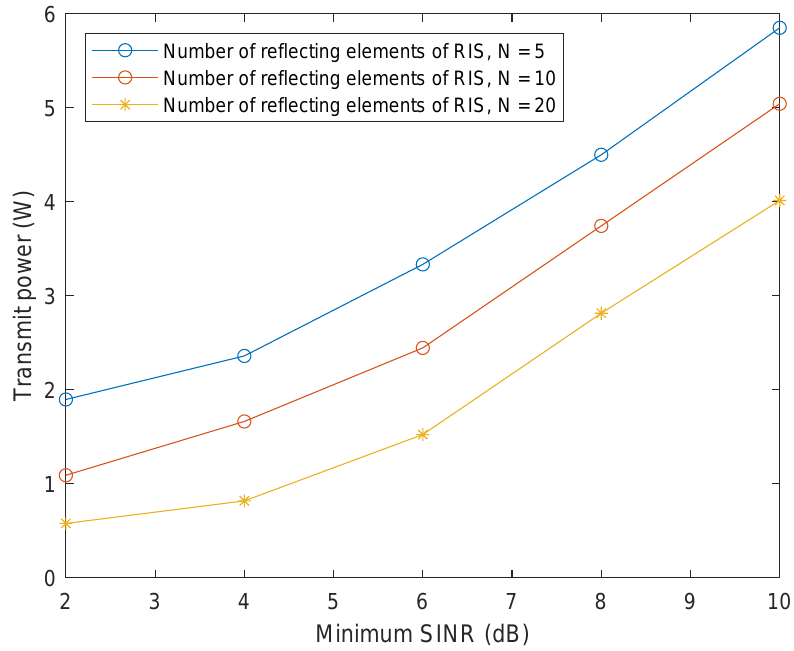
Figure 4. Transmitting power consumption versus sensor’s minimum SINR